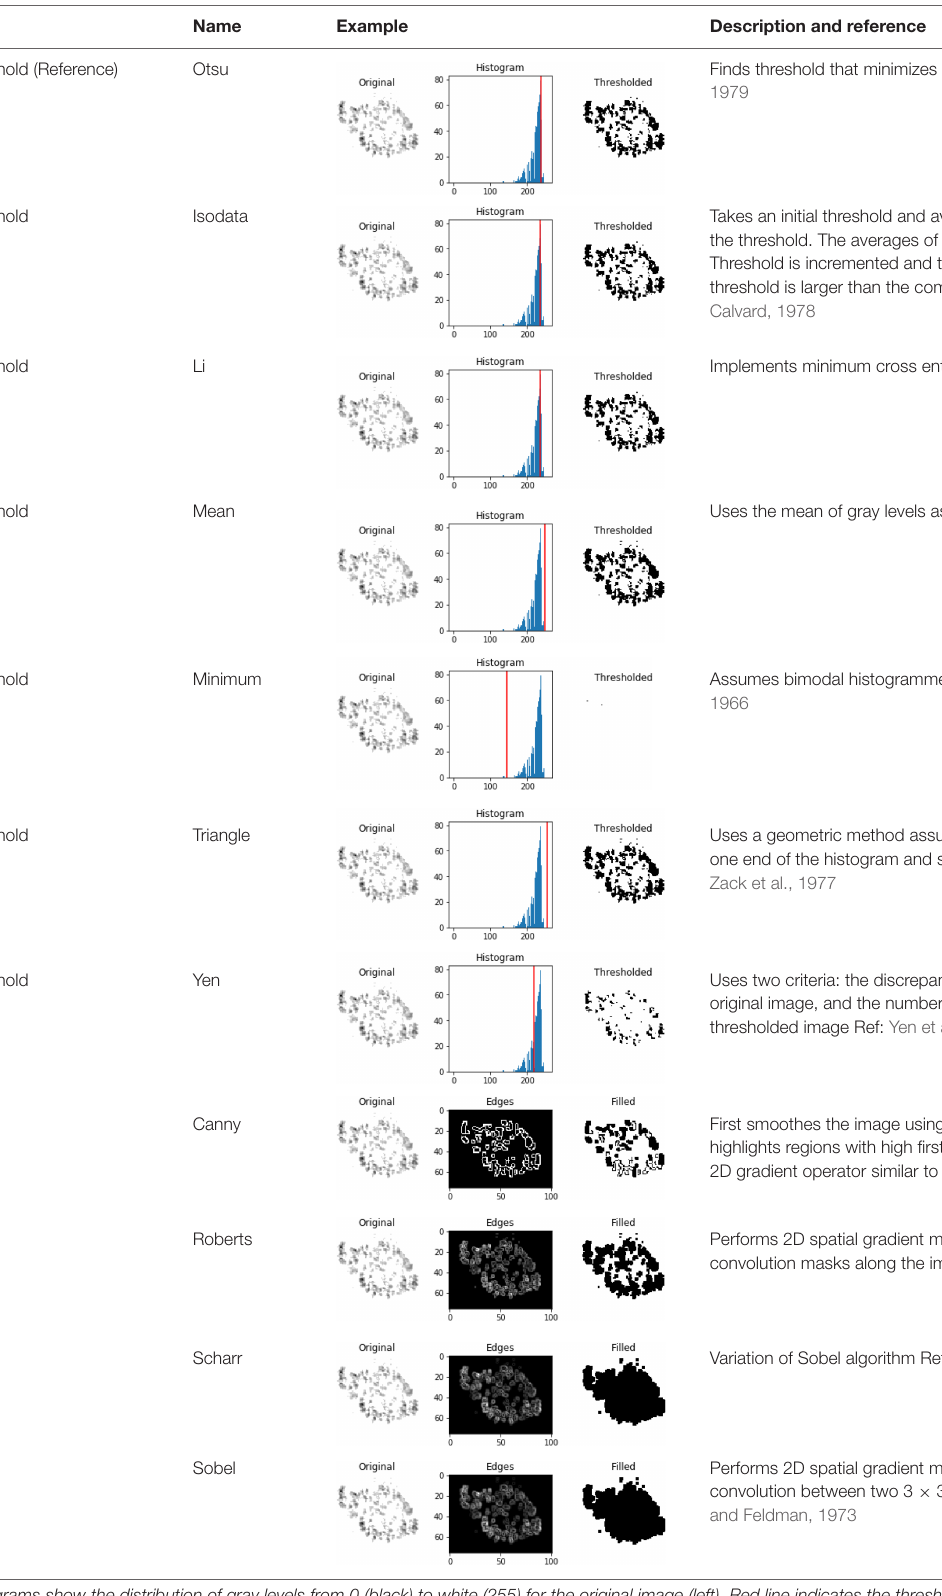
TABLE 1 | Threshold algorithms.